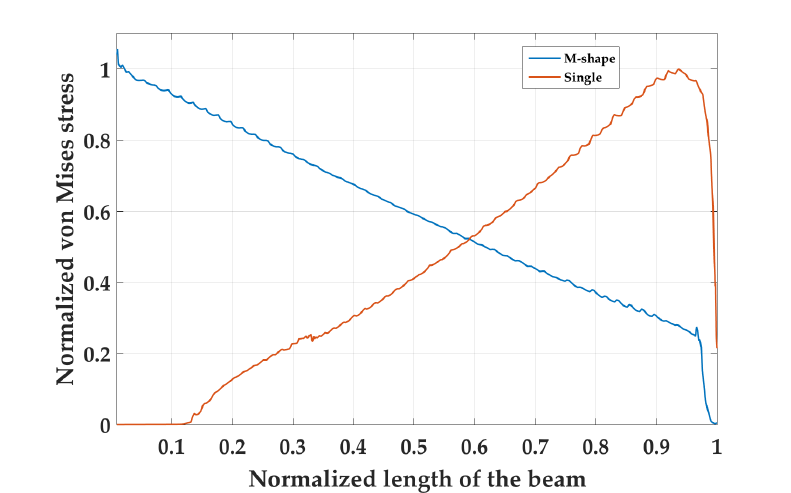
Figure 6. Stress distribution on M-shape across the side beam length compared to a single cantilever at the same natural frequency of 1257